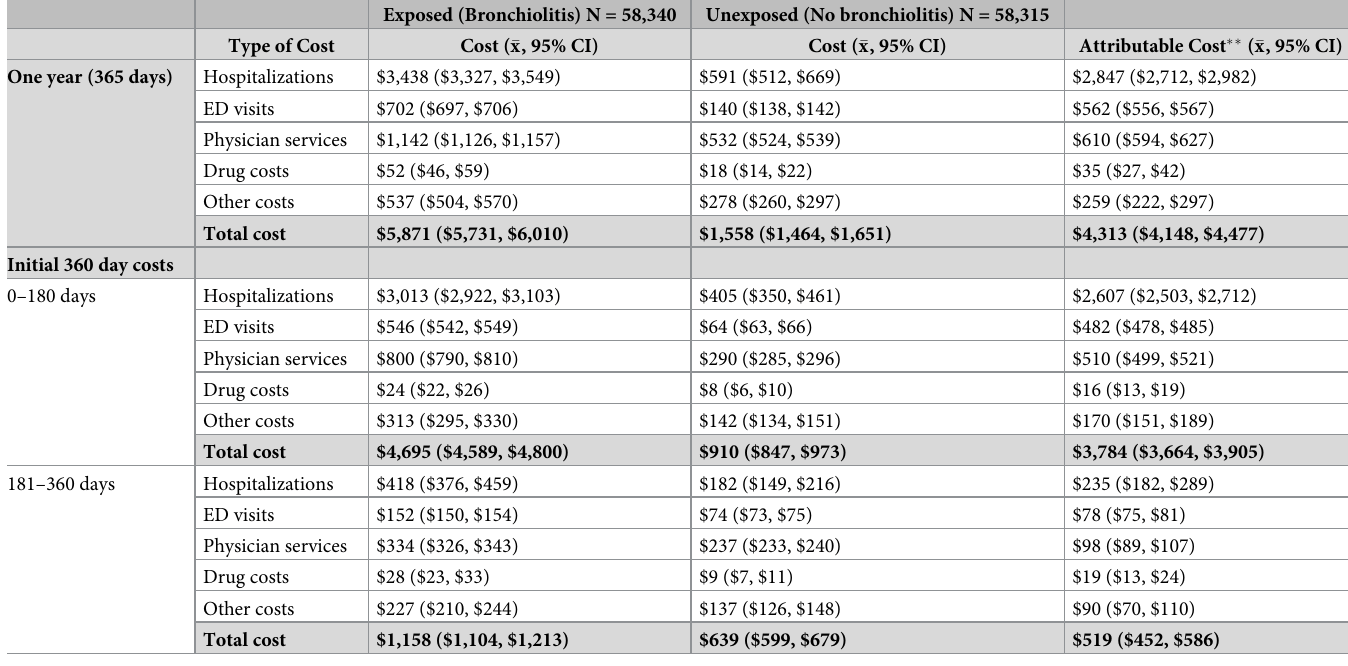
Table 2. Mean attributable costs of bronchiolitis �